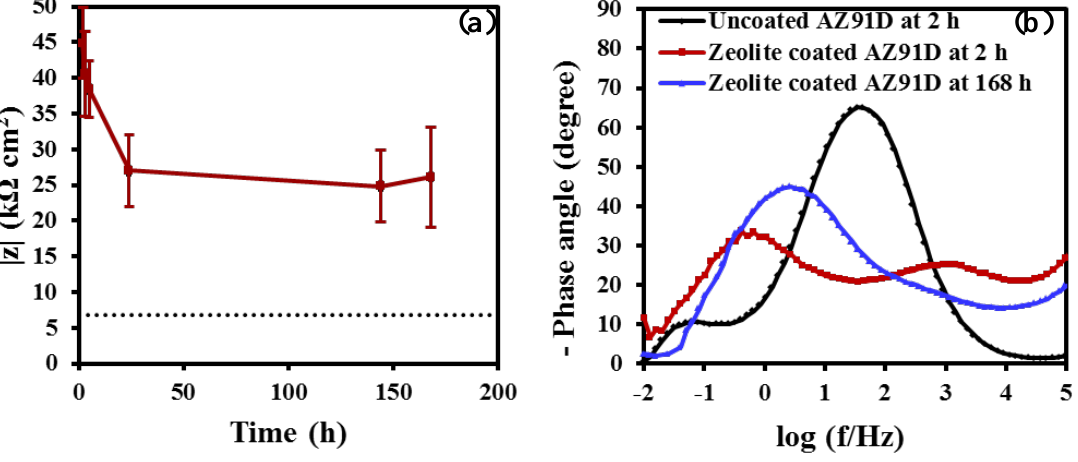
Figure 4. ( a ) Magnitude of impedance of the zeolite coated specimen at different durations of immersion in 0.1 M NaCl solution. The dashed line represents the magnitude of impedance of the uncoated specimen at 2 h of immersion in 0.1 M NaCl solution, and ( b ) phase angle plots of the uncoated and zeolite coated AZ91D specimens at various durations of immersion in 0.1 M NaCl